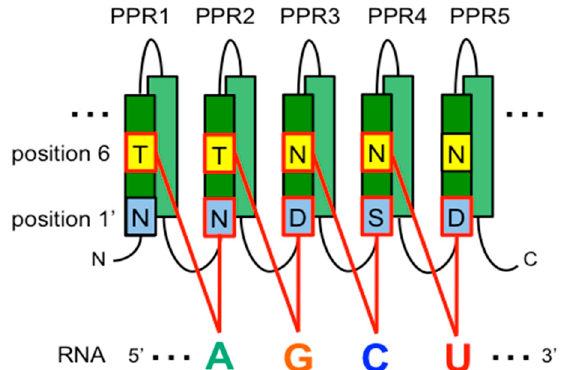
Figure 2. PPR recognition code for RNA binding. Key amino acid positions 6 and 1 ′ of each PPR motif are indicated as yellow and blue colored square boxes, respectively. T, N, D, and S denote amino acids tyrosine, asparagine, aspartic acid, and serine, respectively. Combinations of amino acids at positions 6 and 1 ′ specify binding to specific bases as proposed in Barkan et al. [75]. (T, N) (T at 6, N at 1 ′ ) specify binding to adenine (A), (T, D) to guanine (G), (N, S) to cytidine (C), (N, D) to uridine (U), and (N, N) to C or U.